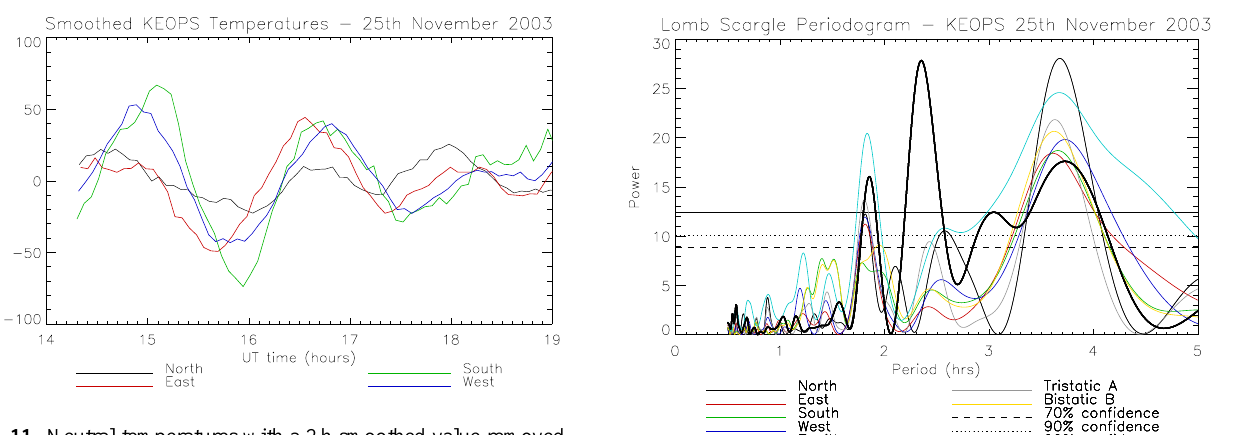
Fig. 11. Neutral temperatures with a 2h smoothed value removed, then with a secondary 40min smoothing, from KEOPS on the 25 November 2003.